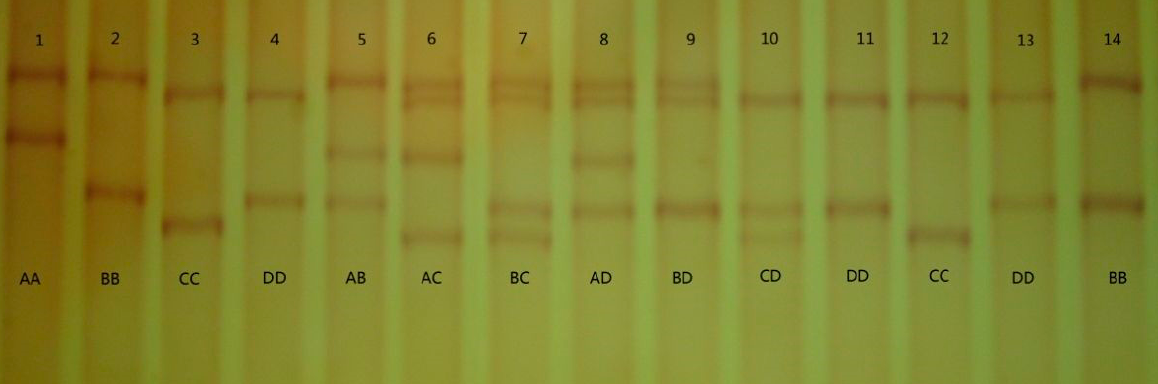
Figure 1. PCR-SSCP analysis of sheep EPAS1 . Different banding patterns came about from paring of four unique variant sequences ( A to D ) in either homozygous or heterozygous forms. Table 2. Sequence variation identified in ovine EPAS1.